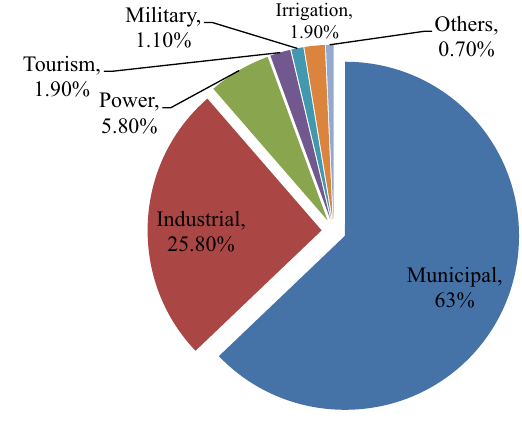
Fig. 6 Shares of freshwater consumption produced in different sectors (Xevgenos et al.